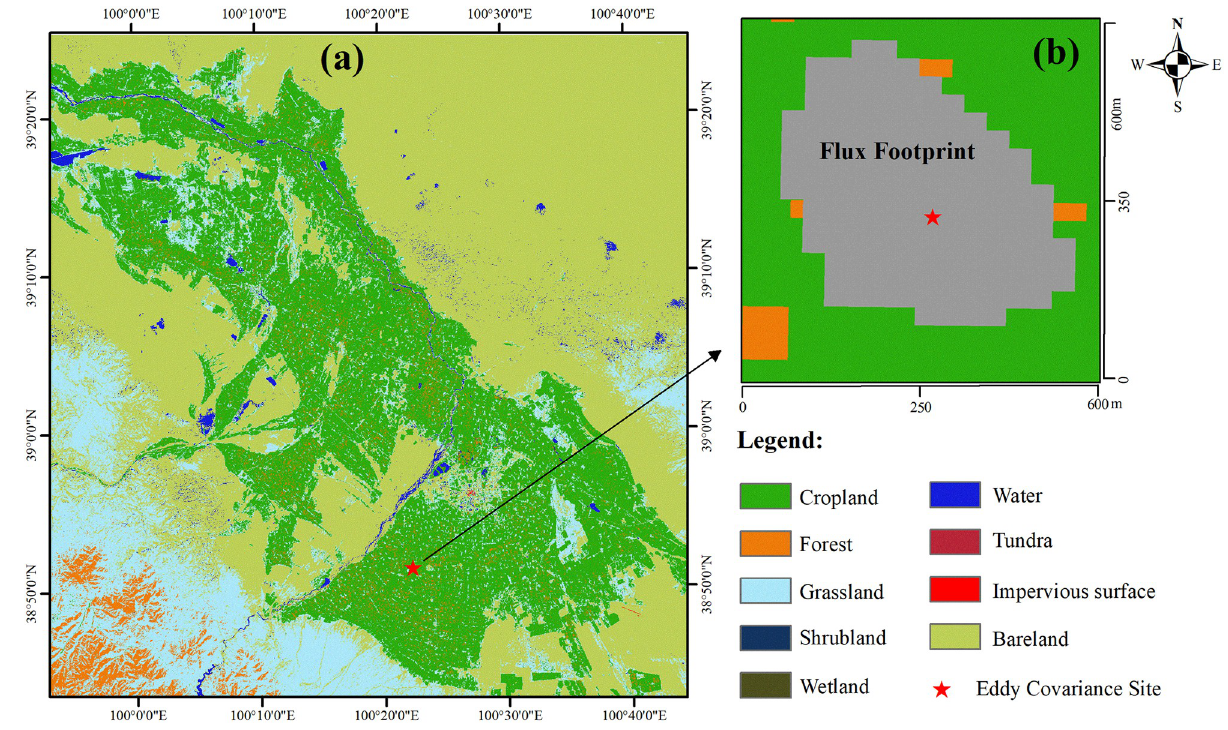
Fig 1. Land cover of the research area (a) and the EC station with its footprint climatology (b).